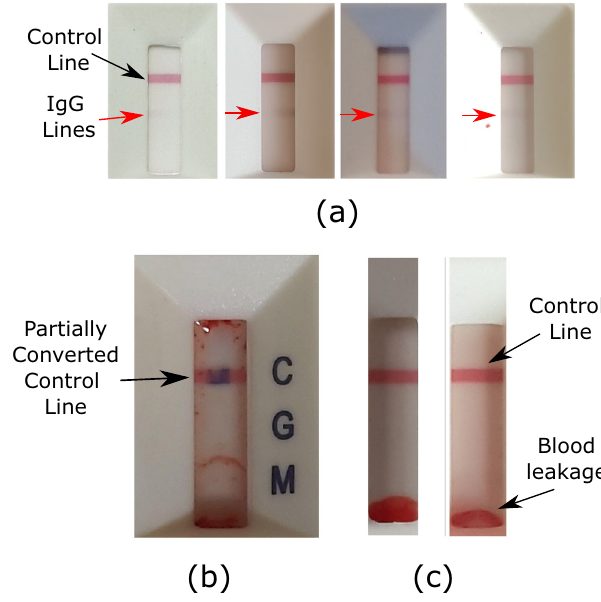
Fig. 2 Examples of issues with the Lateral Flow Immunassay (LFIA) device. a Examples of weak Immunoglobin G (IgG) positive LFIA results. The control line is blue if the test has not been completed, turning red if the sample and buffer have been correctly added. ‘ Weak ’ IgG positives were highlighted as being a challenging scenario for the algorithms to classify correctly. As seen in the examples, the line is faint, and with additional issues of variable lighting. The solution was to introduce more of these cases into the training data. b An invalid LFIA test with a partially converted control line. The method for determining validity looked at the normalised red and blue pixel intensity at the detected control line. A potential source of misclassi fi cation is partial conversion of the control line from blue to